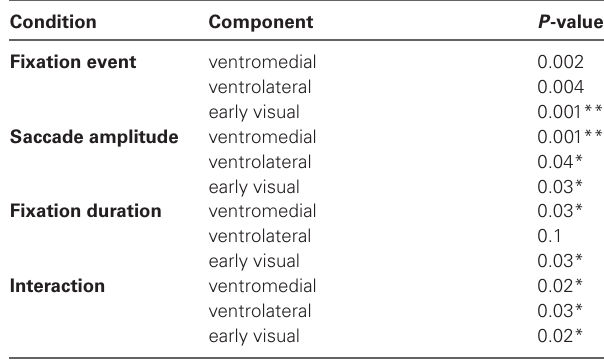
Table 2 | Results per condition of student’s t -tests for each effect size for each cluster significantly different from 0